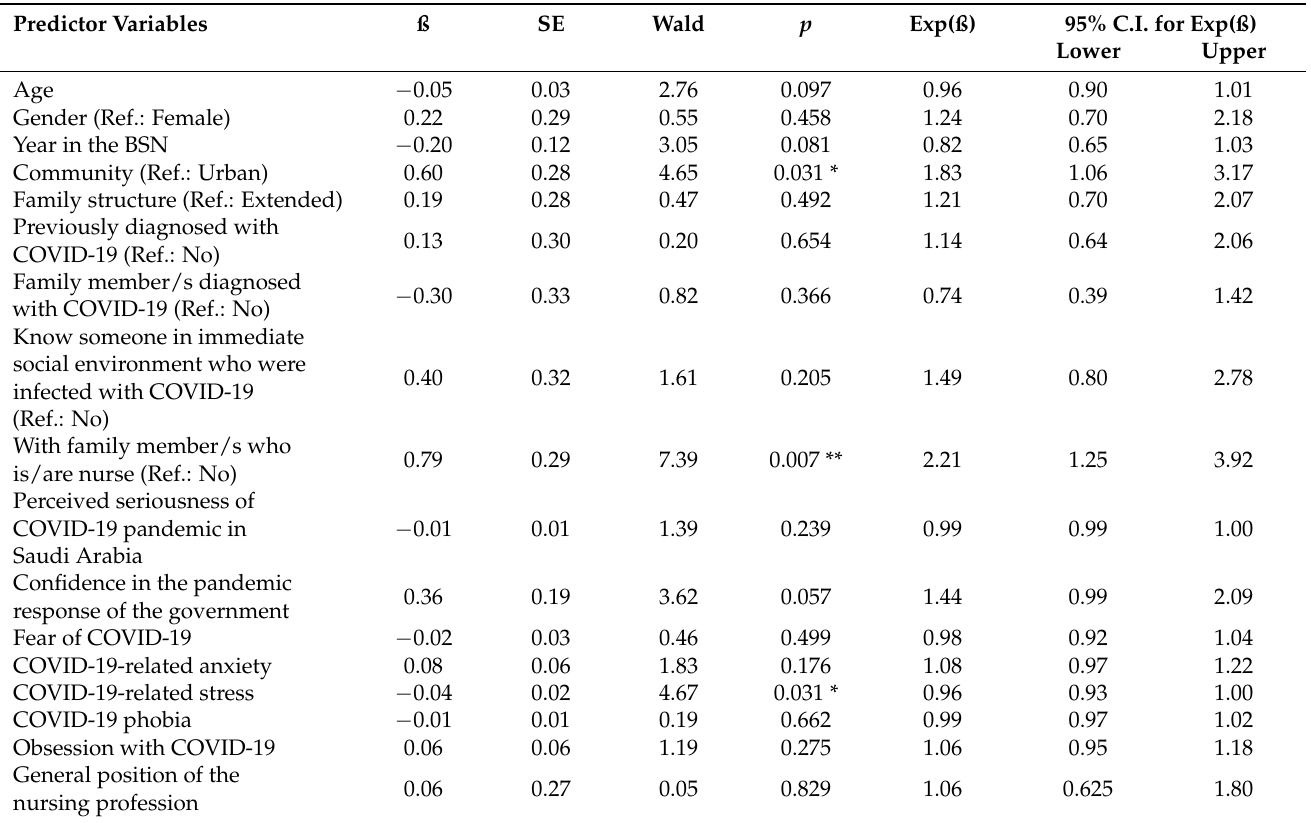
Table 4. Result of the binary logistic regression on the willingness of the students to continue with nursing as their future profession ( n =